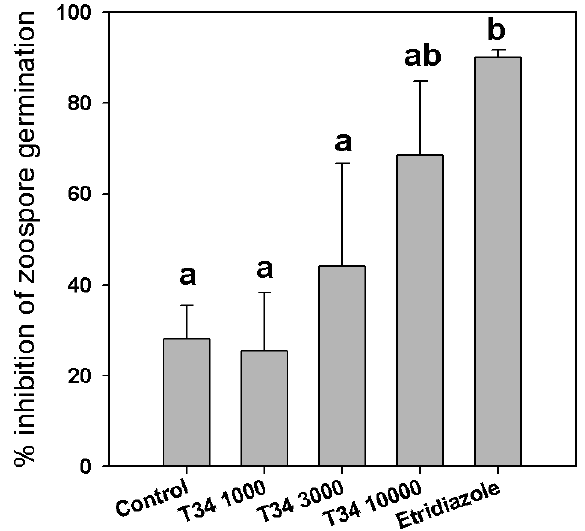
Figure 4. Inhibition of zoospore germination (%) after 24 h of incubation of a mixture of equal volumes of Phytophtho- ra capsici and treatments. Control, water; T34 1,000, 3,000 and 10,000, Trichoderma asperellum strain T34 at 10 3 , 3 × 10 3 and 10 4 conidia ml -1 ; Etridiazole, Terrazole ® at 2 L ha -1 . Dif- ferent letters indicate significant differences within treat - ments, Duncan’s multiple range test ( P